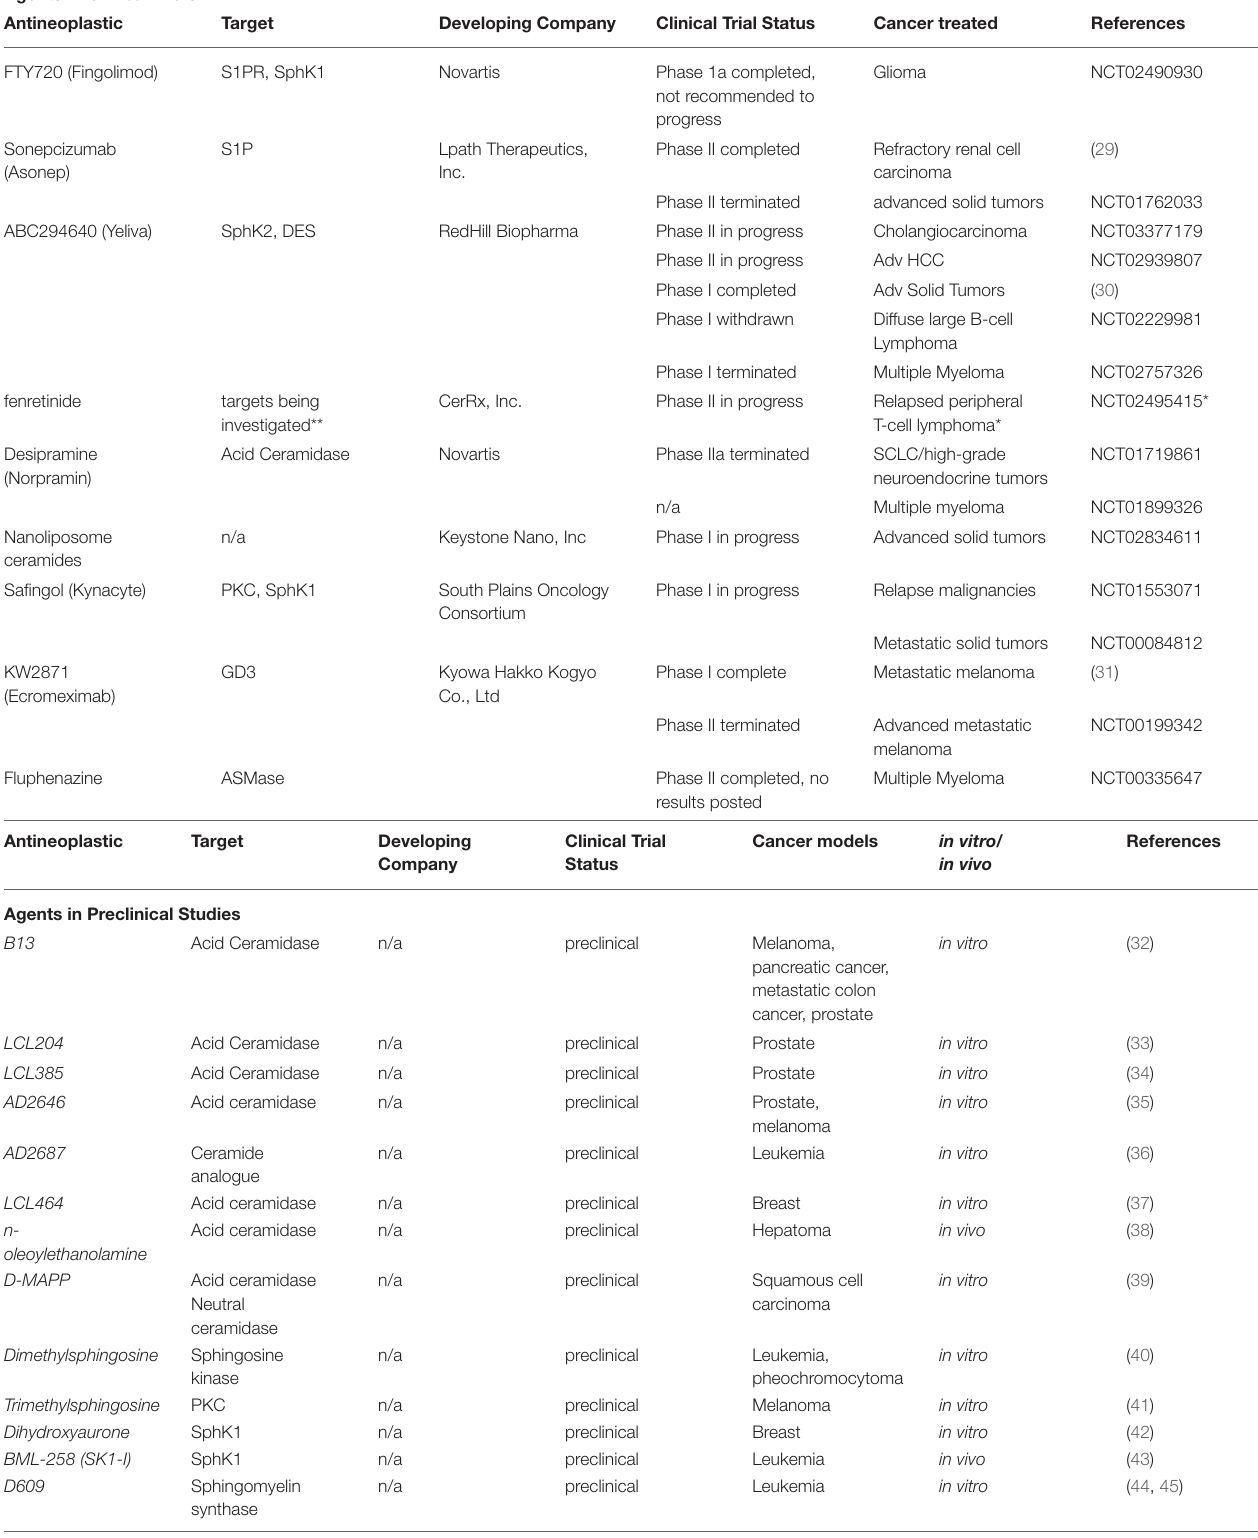
TABLE 1 | Antineoplastic agents targeting sphingolipids that are in